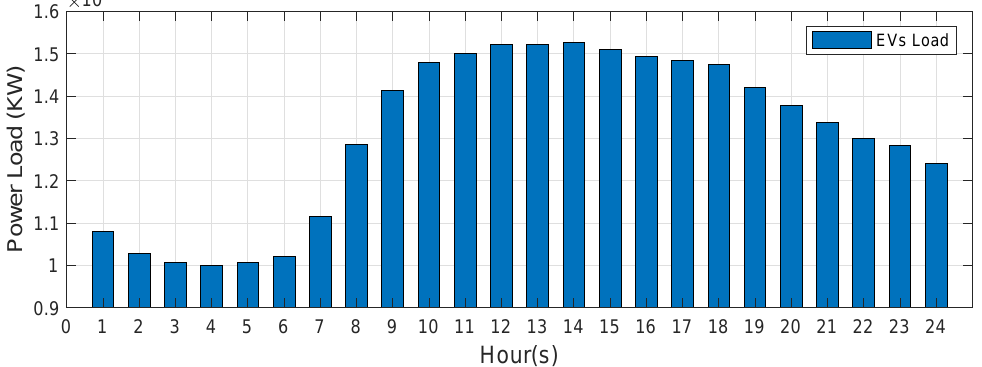
Figure 8. The EV units power load of one day.